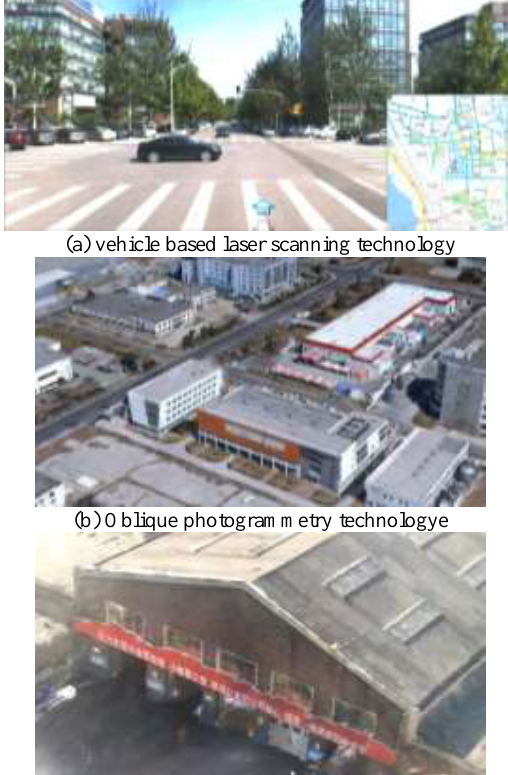
Figure 1. Different techniques to obtain 3D streetscape